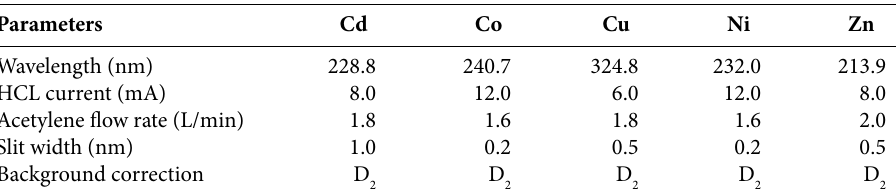
Table 2. AAS parameters used in the determination of Cd, Co, Cu, Ni and Zn